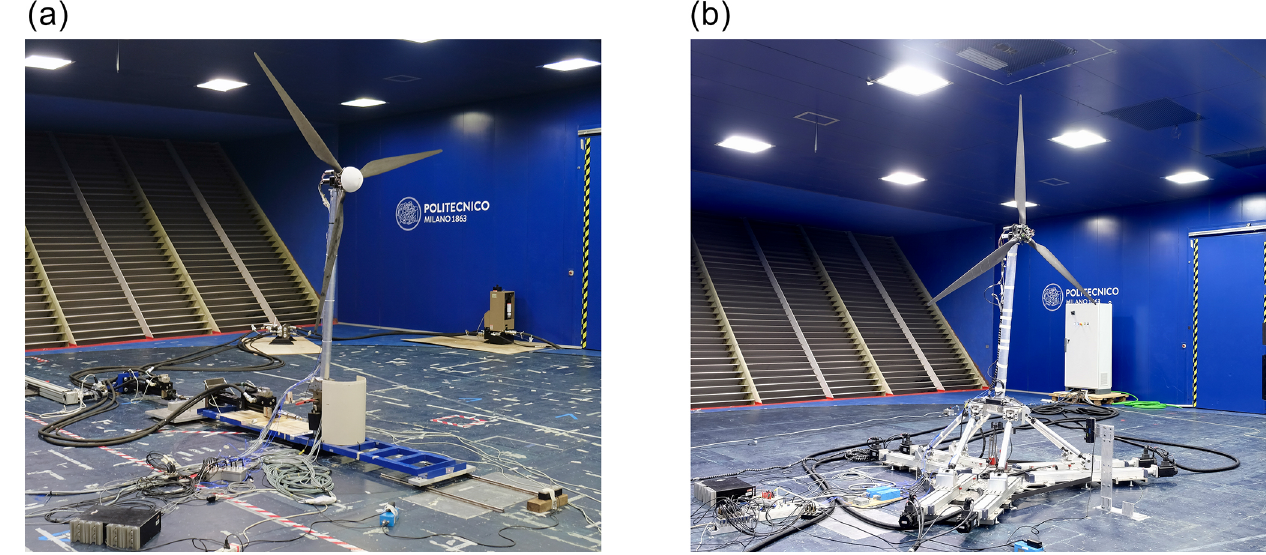
Figure 1. The 1 : 75 scaled DTU 10MW reference wind turbine in the Politecnico di Milano wind tunnel. (a) Testing during the UNAFLOW campaign (Experiment 1). (b) Testing during the follow-on campaign (Experiment 2). Table 2. System geometry.